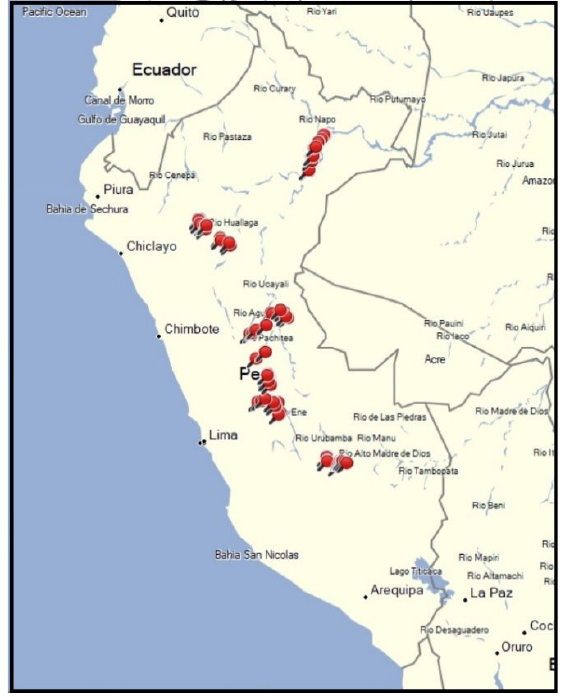
Figure 1. Sites (red dots) where the 149 achiote accessions were collected. Table 1 . Average locations of collection points of achiote accessions by